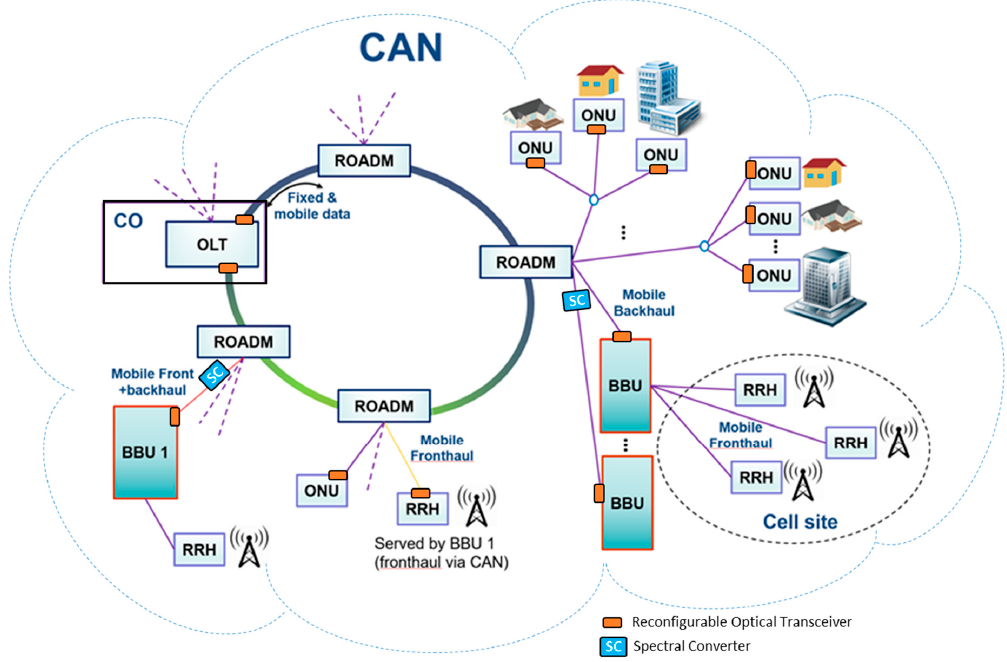
Figure 3. Cloud Access Network (CAN) Architecture.